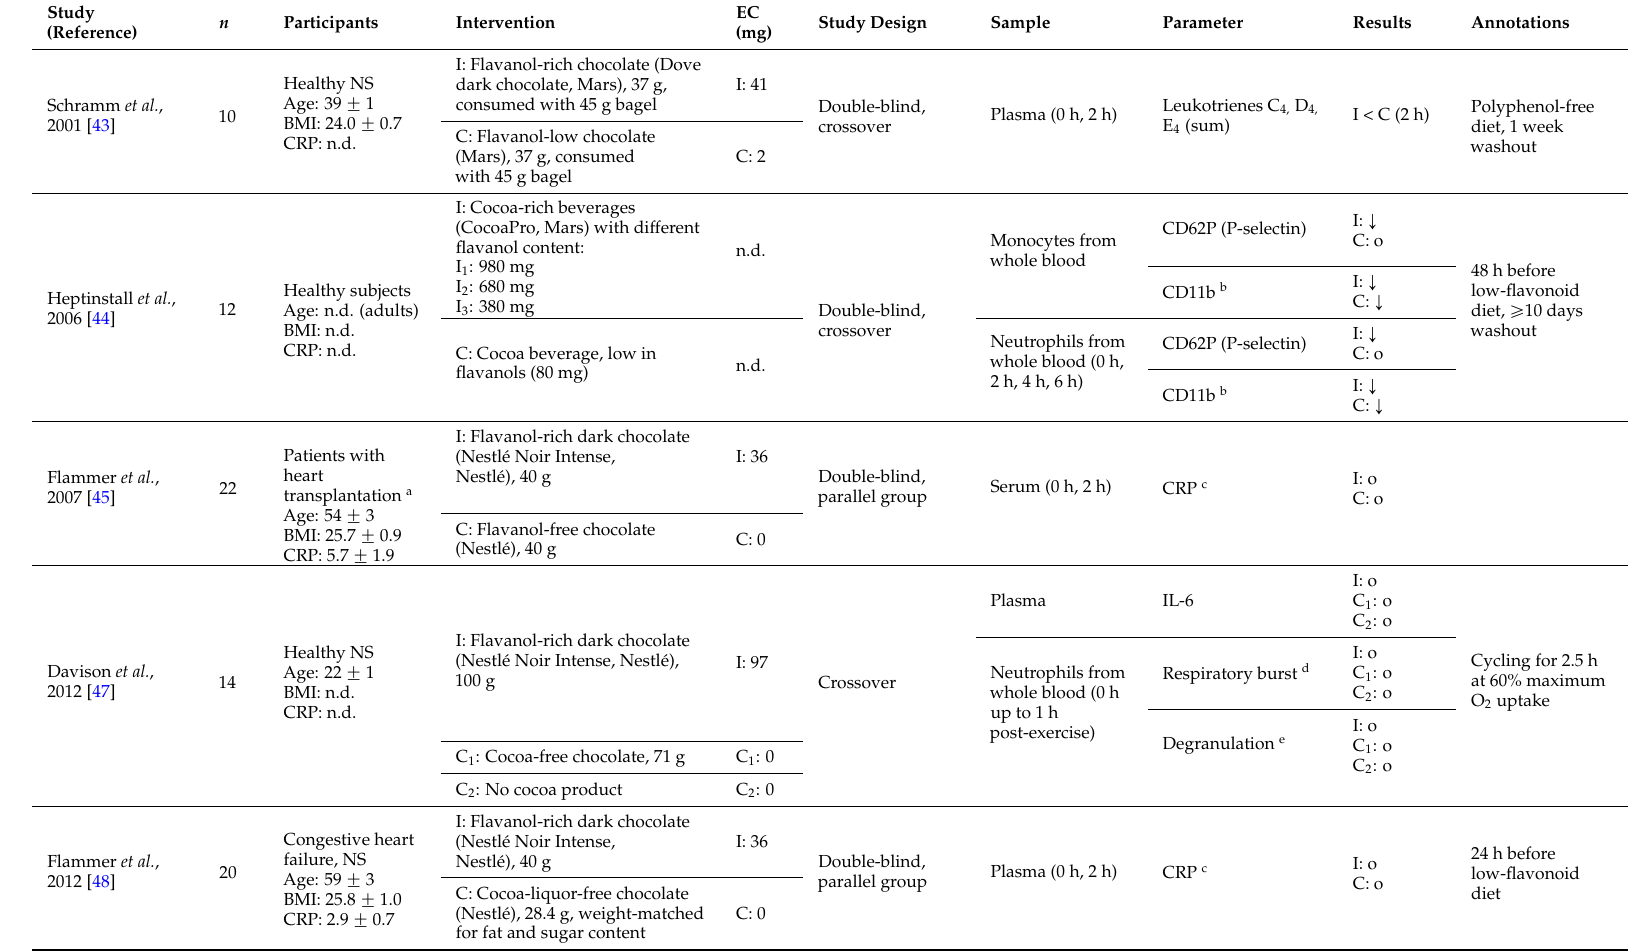
Table 1. Effect of bolus consumption of cocoa on inflammation—results from randomized, controlled